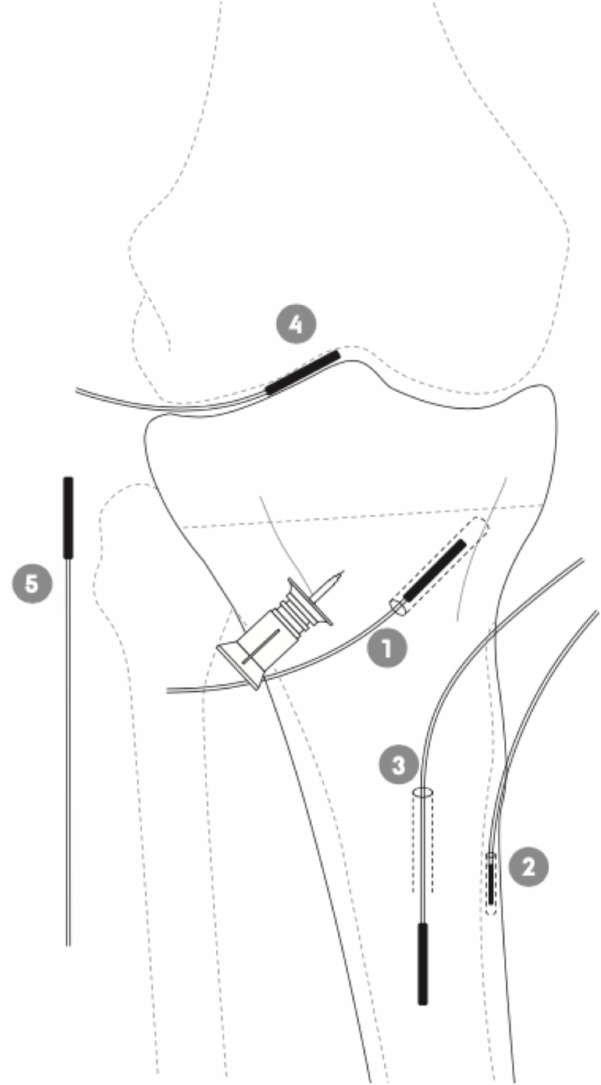
Figure 1. Schematic illustration of the placement of the tibial in- traosseous cannula and the microdialysis probes in adjacent cancel- lous bone (1), cortical bone (2), intramedullary canal (3), synovial fluid of the knee joint (4), and subcutaneous tissue (5) in a porcine